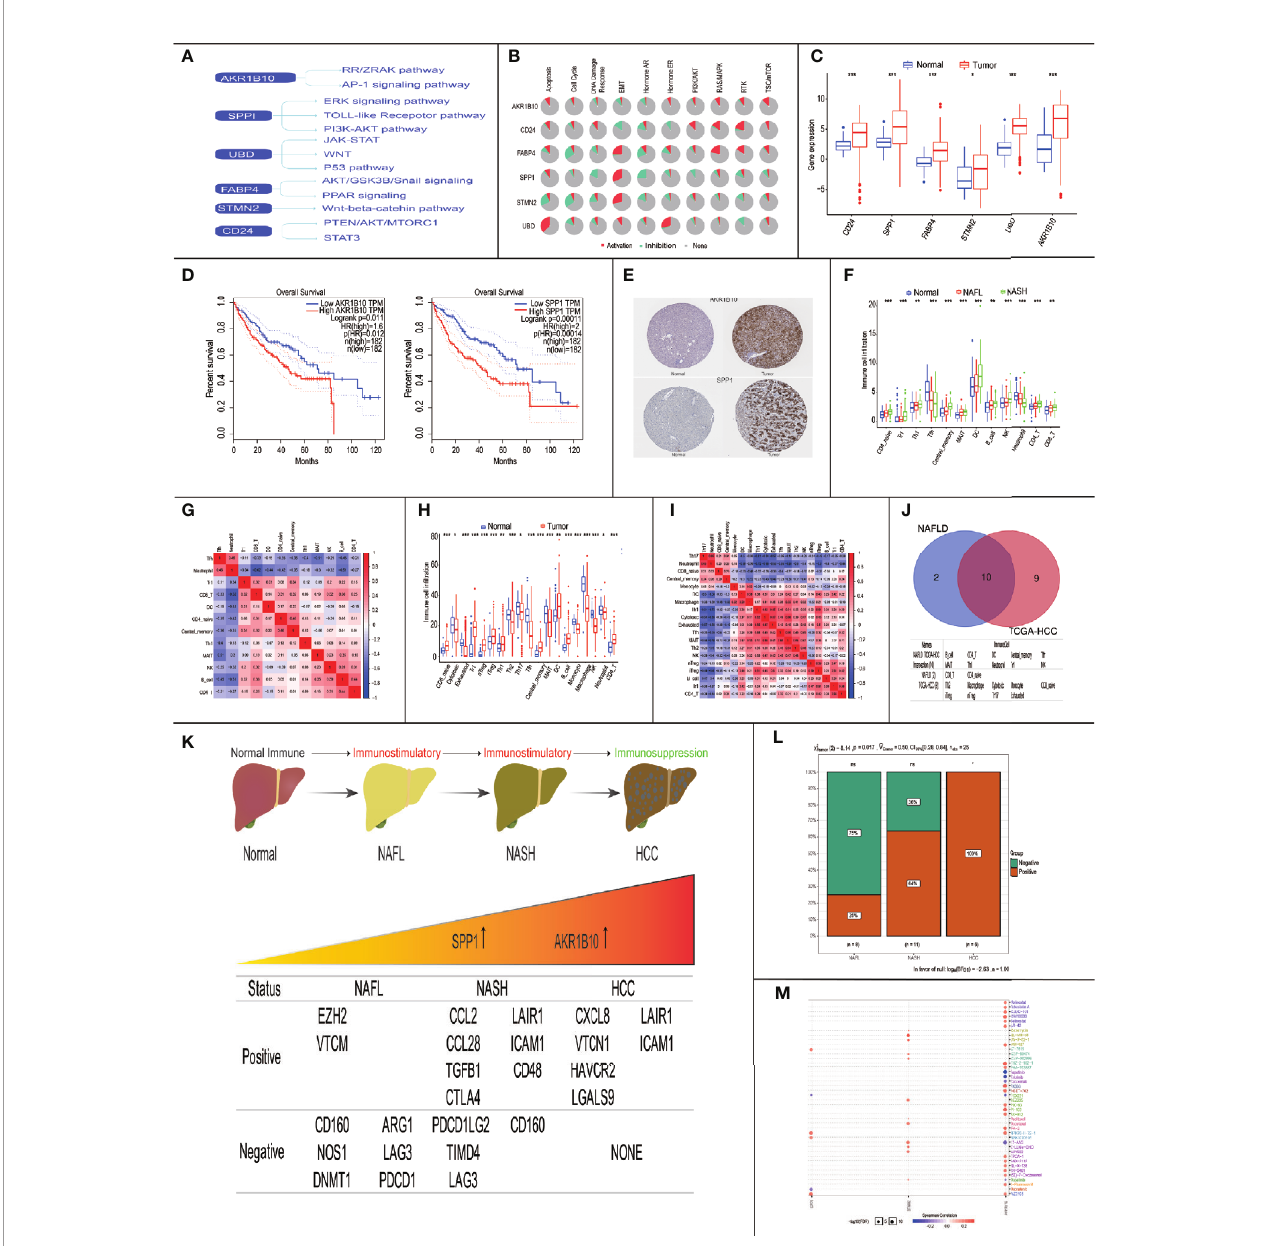
FIGURE 8 | Immune landscape and treatment prediction in NAFLD patients and HCC patients. (* P< 0.05, ** P< 0.01, *** P< 0.001). (A) Literature-based of six progress-related genes in HCC-associated signaling pathways; (B) Enriched pathways of 6 progress-related genes in TCGA database; (C) Expression of progress- related genes between normal patients and HCC patients in the TCGA database; (D) Survival analysis of AKR1B10 and SPP1; (E) Protein expression of AKR1B10 and SPP1 between normal patients and HCC patients; (F) Boxplots visualizing the difference of immune cell in fi ltration in Normal/NAFL/NASH patients; (G) Correlation analysis of immune cells in Normal/NAFL/NASH patients; (H) Boxplots visualizing the difference of immune cell in fi ltration in normal/HCC patients; (I) Correlation analysis of immune cells in Normal/HCC patients; (J) The intersection of immune cells between NAFLD patients and HCC patients; (K) The relationship between immunosuppressive cytokines expression and AKR1B10/SPP1; (L) Chi-square test of immunosuppressive cytokines expression in the progress of NAFLD; (M) Drug sensitivity analysis of AKR1B10 and